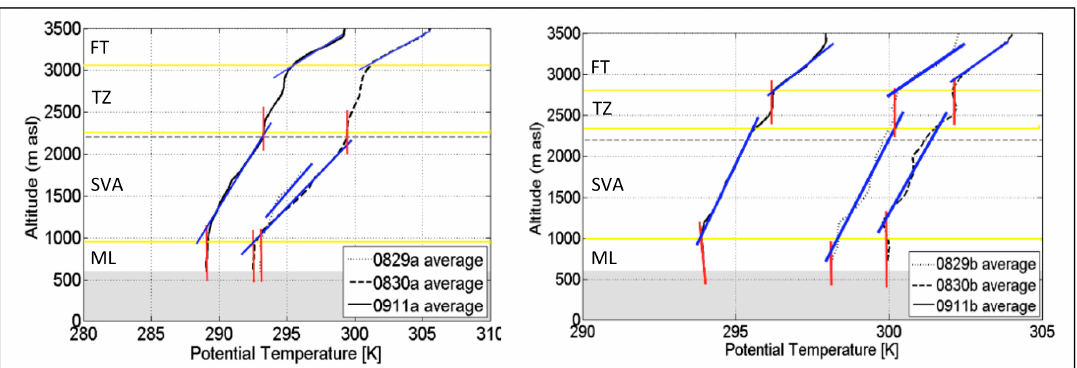
Figure 3. Profiles of potential temperature in the Inn Valley, Austria, from airborne measurements [55] using a spatial interpolation scheme [56]. Mean profiles along the valley axis are shown for the morning ( left panel) and afternoon flights ( right panel) on 29 and 30 August and 11 September 2013. Horizontal yellow lines depict diagnosed layers (the Mixed Layer ML, the Stable Valley Atmosphere SVA, the Transition Zone TZ, and the Free Troposphere FT, respectively), while red and blue straight lines correspond to interpreted layer characteristics, superimposed on the measurements. The horizontal dashed line corresponds to the mean terrain height. Adapted from Markl [7].